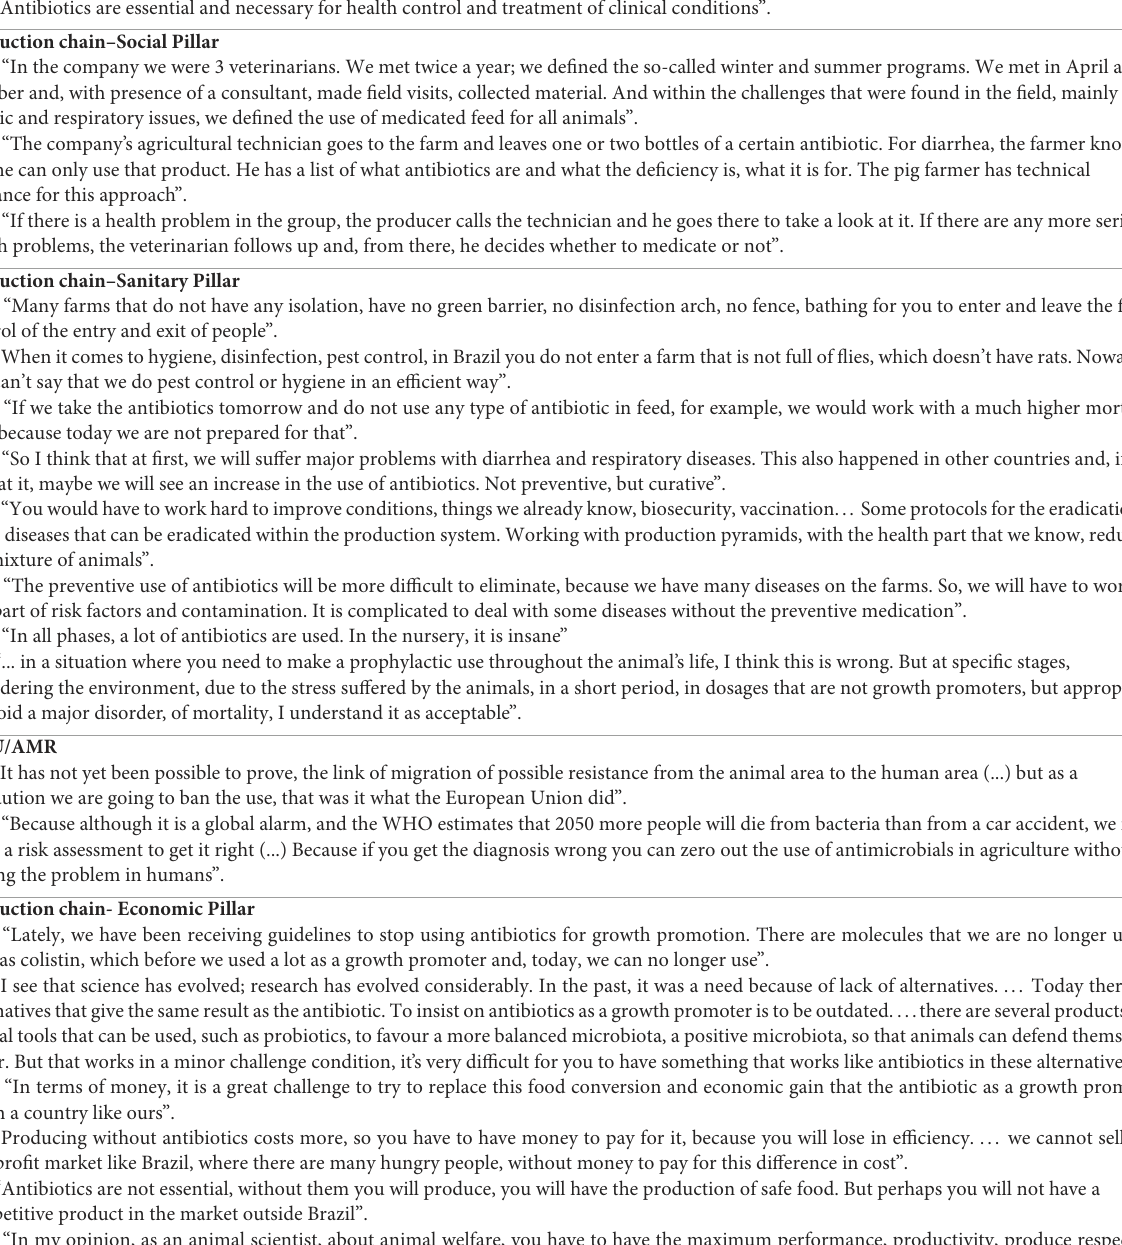
TABLE 1 Quotes by high